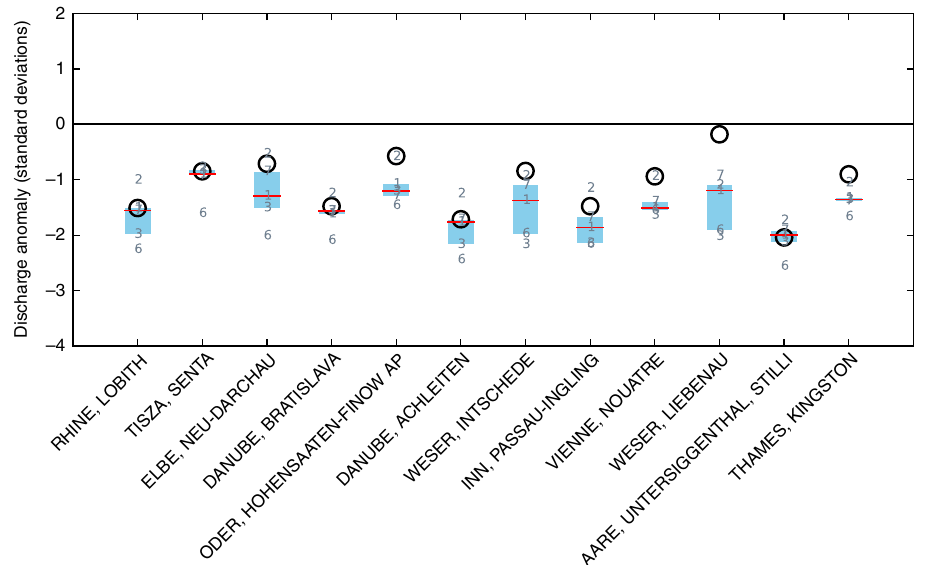
Fig. 2 August average river discharge anomalies in 2003. Black circles are observed (GRDC) data. Grey numbers are the global hydrological models (see Methods); red lines indicate the median, and blue boxes the interquartile range, of the model ensemble. Stations are ordered by catchment size; the smallest catchment (Thames river at Kingston) has an area of about 10,000 km 2 , which corresponds to the size of four model grid